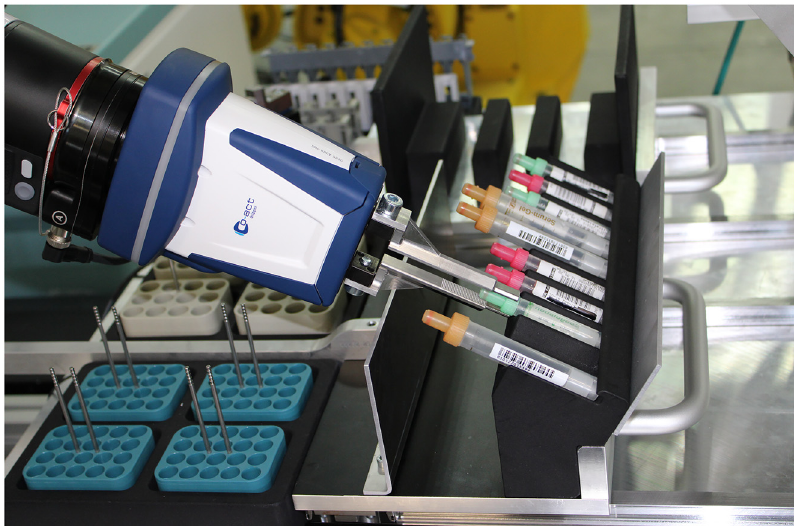
Figure 2: Sample entry: Robot picks